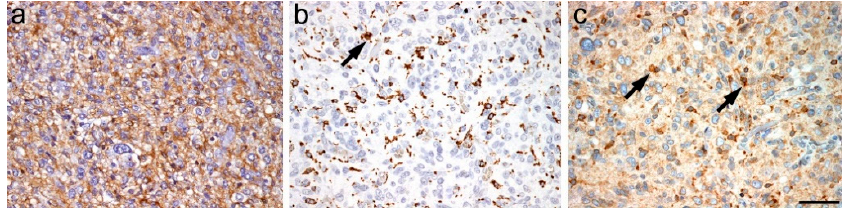
Figure 1. ( a ) GFAP staining of glioblastoma tumor cells; ( b ) CD68 positivity of tumor associated microglia and macrophages; ( c ) SOAT1 expression in GBM (scale bar 200 µm).